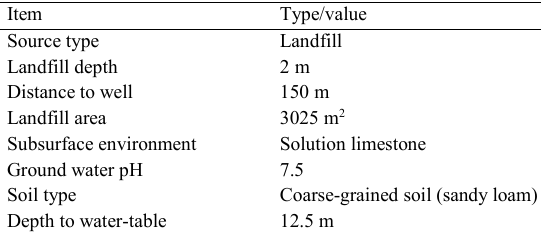
Table 5: Surface, subsurface and landfill data